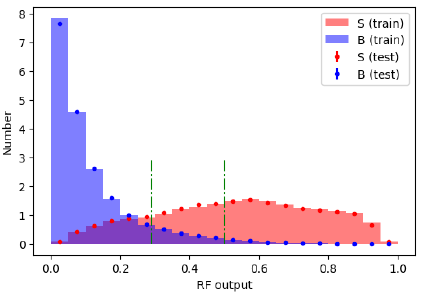
Figure 9 . RF output for the training (bars) and testing (points) samples. The doted-dashed green lines correspond to \RF I" and \RF II" signal bins, see table 5.